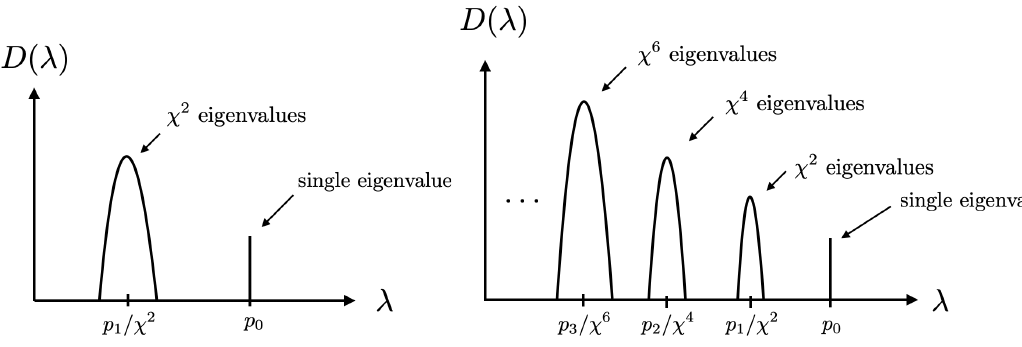
Figure 4 . Sketch of spectrum of 1TN vs 2TN. While the 1TN model has two peaks corresponding to the connected and disconnected phases, the 2TN model has infinitely many peaks corresponding to the novel, higher-genus saddles discovered in section